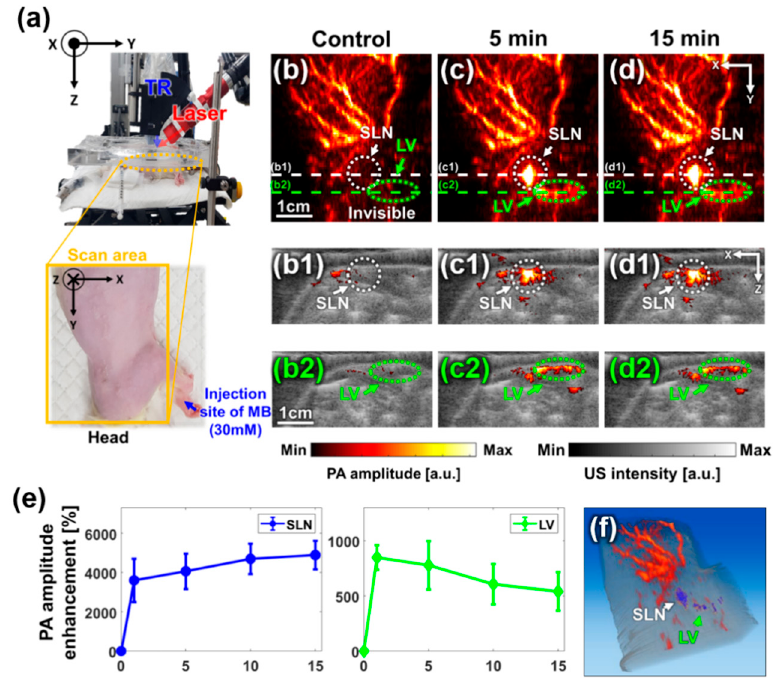
Figure 4. In vivo PA images of the rat sentinel lymph node over time. ( a ) Photographs of the experimental setup for in vivo rat imaging and the region of interest. ( b – d ) In vivo PA maximum amplitude projection (MAP) images of the rat over time. ( b1 – d1 ) Cross-sectional overlaid B-mode PA/US images cut along the white, dashed lines in Figures ( b – d ), respectively. ( b2 – d2 ) Cross-sectional overlaid B-mode PA/US images cut along green, dashed lines in Figures ( b – d ), respectively. ( e ) PA amplitude enhancement of the SLN and LV over time after injecting MB. ( f ) Snapshot of volume-rendered PA/US image (Supplementary Video S2). TR, transducer; MB, methylene blue; PA, photoacoustic; US, ultrasound; SLN, sentinel lymph node; LN, lymph node; and LV, lymph vessel, and a.u., arbitrary unit.